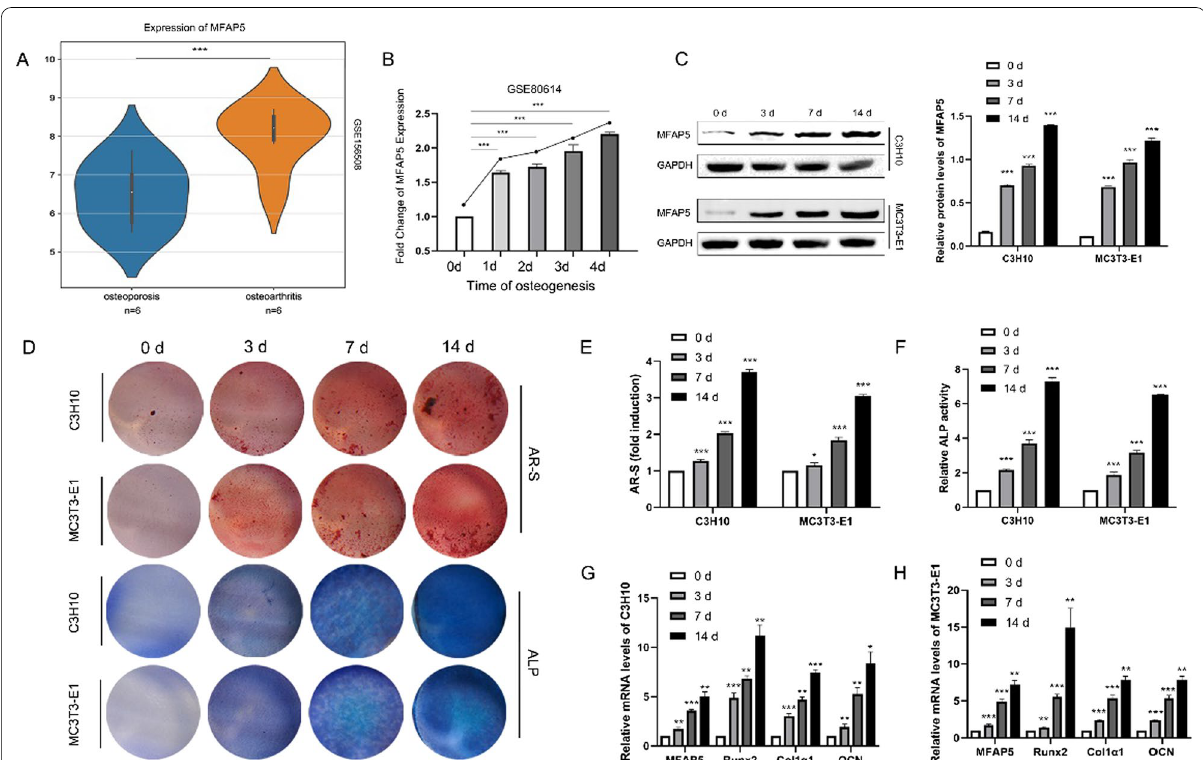
Fig. 1 MFAP5 expression was associated with osteogenesis. A MFAP5 expression was lower in the BMSCs of patients with osteoporosis compared to those with osteoarthritis. B Osteogenic induction of human mesenchymal stromal cells (hMSCs) at 0, 1, 2, 3, and 4 days showed that the level of mRNA encoding MFAP5 was positively associated with osteogenesis. C The expression patterns of MFAP5 in C3H10 and MC3T3-E1 cells during osteogenic differentiation, as revealed by Western blotting and the quantitative results of Western blotting. D Mineralized nodules and ALP expression revealed by AR-S and ALP staining during the osteogenesis of C3H10 and MC3T3-E1 cells. E The relative ALP expression levels of the two cell lines. F Quantitation of AR-S staining of C3H10 and MC3T3-E1 cells. G and H The levels of mRNAs encoding MFAP5, Runx2, Col1α1, and OCN of both cell types during osteogenesis. Values are expressed as means standard deviations (*P < 0.05, **P < 0.01, ***P < ±